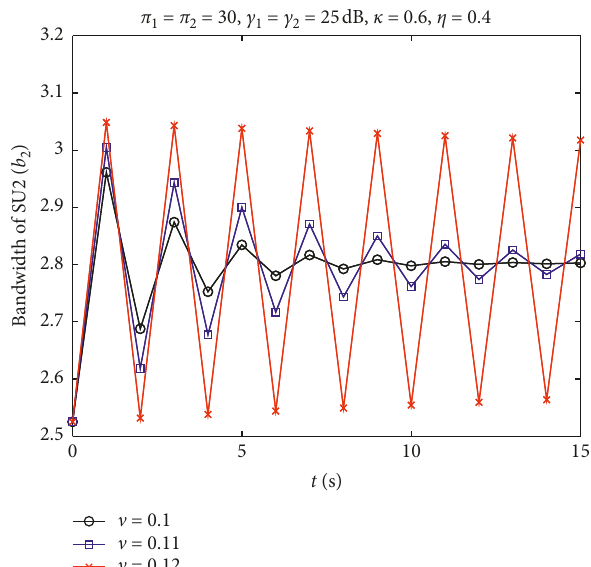
Figure 7: The dynamic behavior of the non-cooperation game for the V-SU 2.